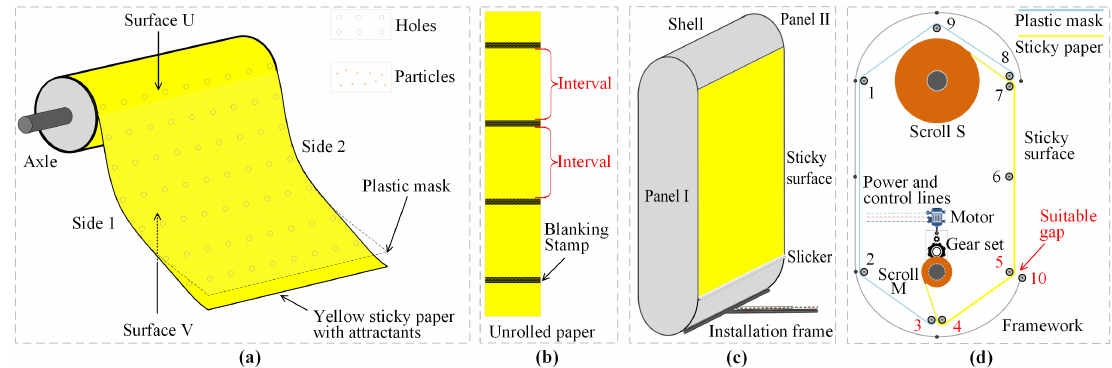
Figure 2. ( a ) Processing of two-layer sticky paper with attractants. ( b ) A demonstration of the unrolled paper with blanking stamps. ( c ) Appearance of trap. ( d ) A sectional view of a motor-driven